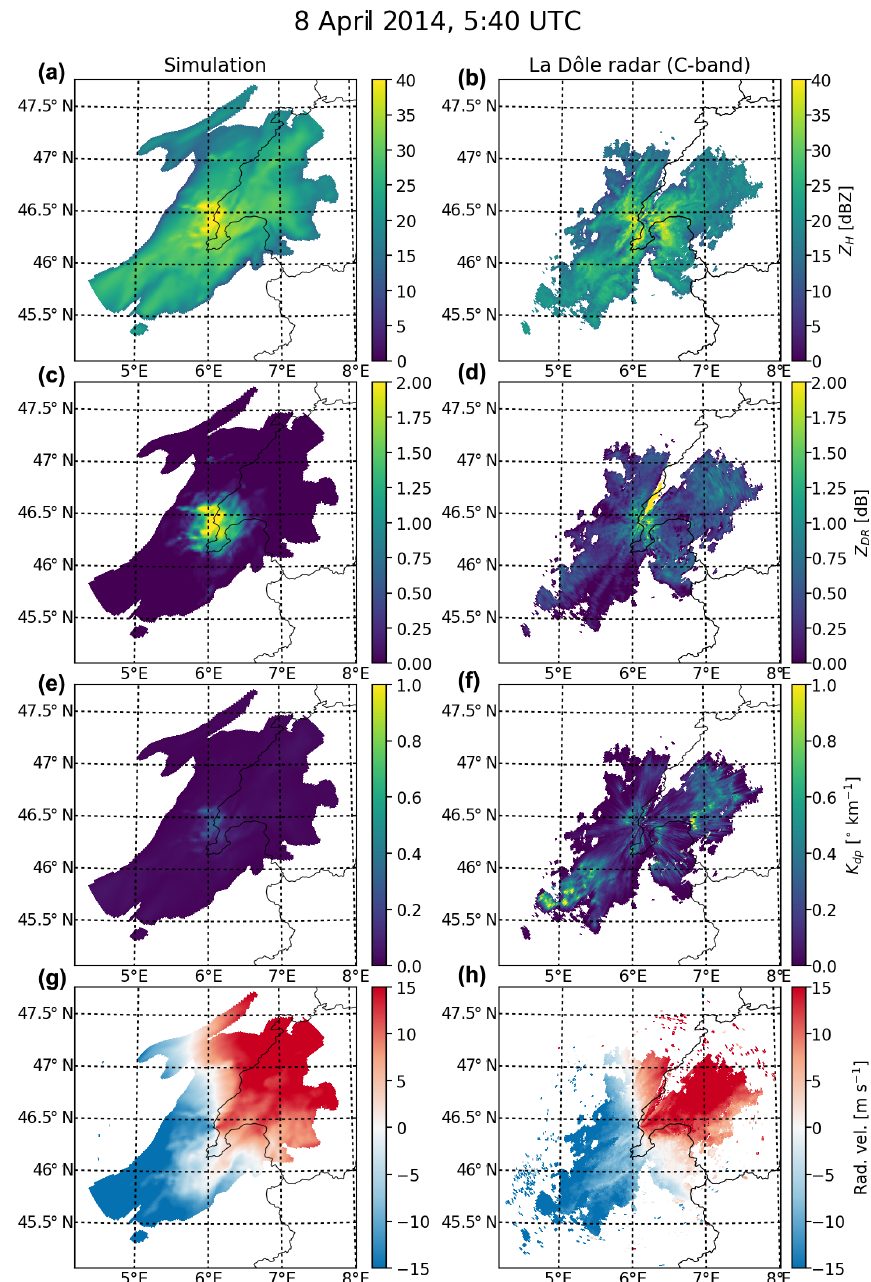
Figure 11. Same as Fig. 10 but for the stratiform event on the 8 April 2014 (Table